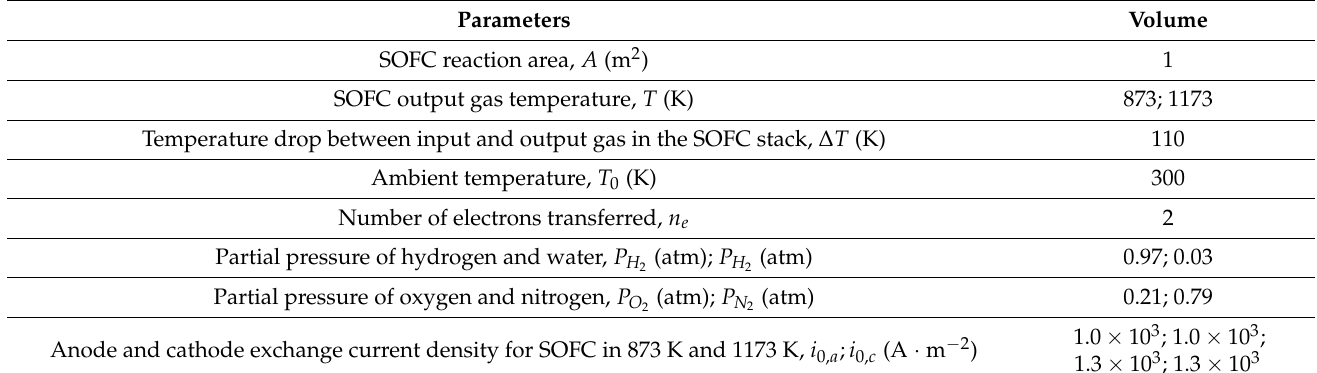
Table 1. Operation parameters of the hybrid SOFC-SE system [24]. Parameters